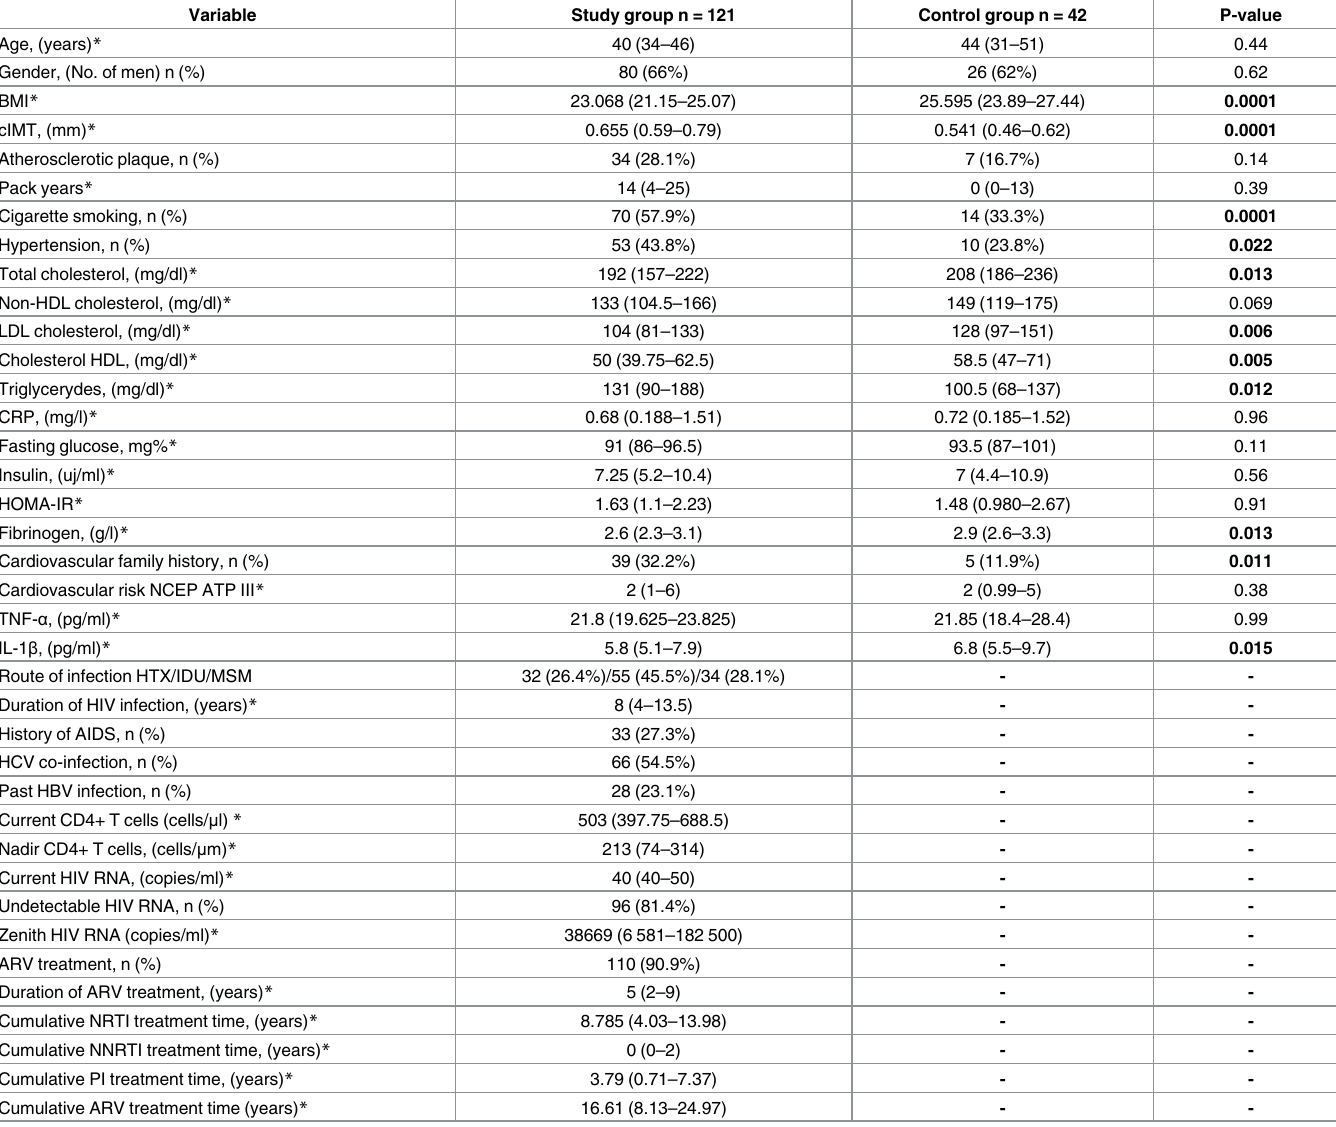
Table 1. Characteristics of the study group and control group: The parameters of subclinical atherosclerosis, cardiovascular risk and risk factors. Data on the virological status, immunological status and antiretroviral treatment.